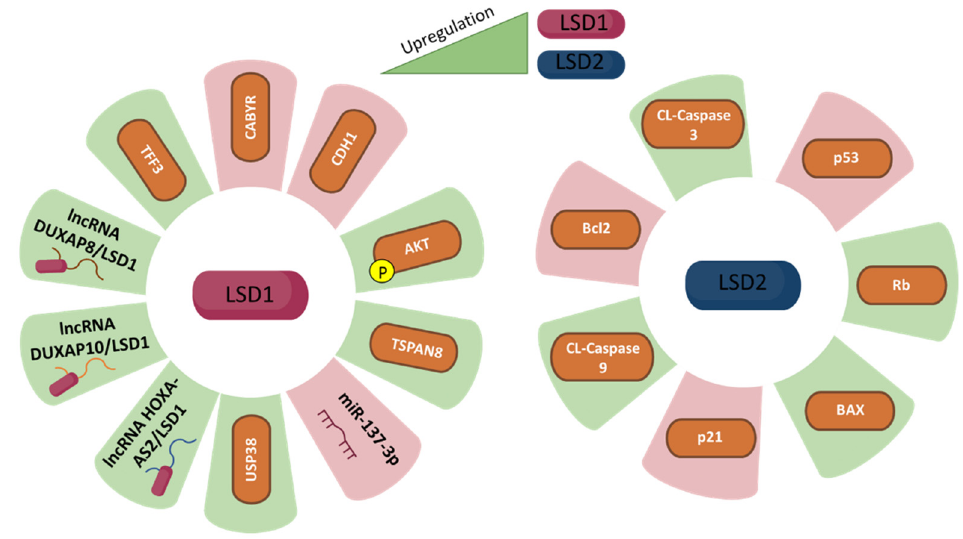
Figure 4. LSD1 ( left panel) and LSD2 ( right panel) expression and its correlation with colorectal cancer fate. The green colour represents upregulation while purple represents downregulationof each specific molecule, which are related to LSD1 and LSD2 upregulation, respectively. Table 4. Recent studies on LSD1/2 in colorectal cancer.